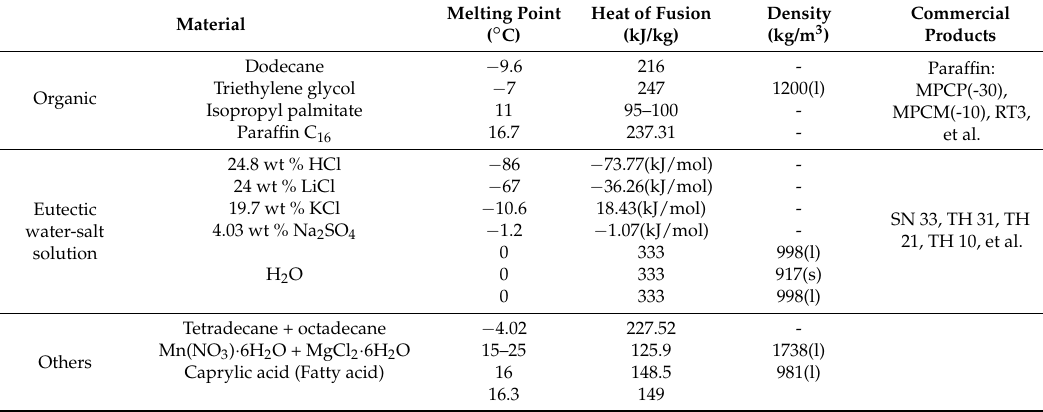
Table 8. Thermophysical properties of materials for cold storage (melting temperature up to 20 ◦ C)